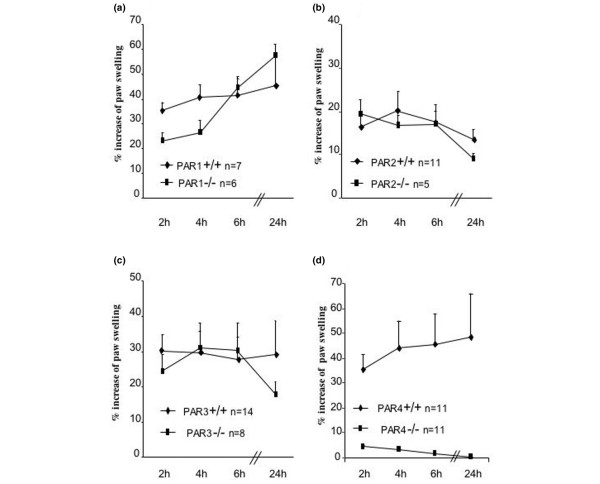
Analysis of soluble tissue factor-induced inflammation in protease activated receptor-deficient mice. Soluble tissue factor (1 μg) was injected into the footpad of mice with individual deficiency for one of the four different protease activated receptors (PARs). (a) PAR-1-deficient mice. (b) PAR-2-deficient mice. (c) PAR-3-deficient mice. (d) PAR-4-deficient mice. In each experiment, footpad swelling was assessed in the PAR-deficient mice and their littermates (+/+ or +/-) as controls.